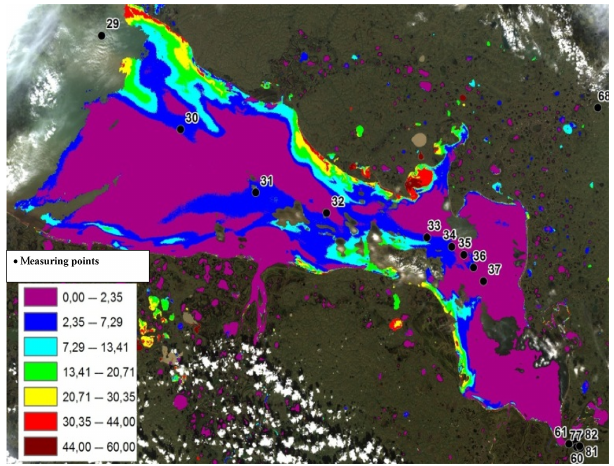
Figure 4. CHL distribution according to Landsat-8 data, mgm − 3 (31 July 2015).